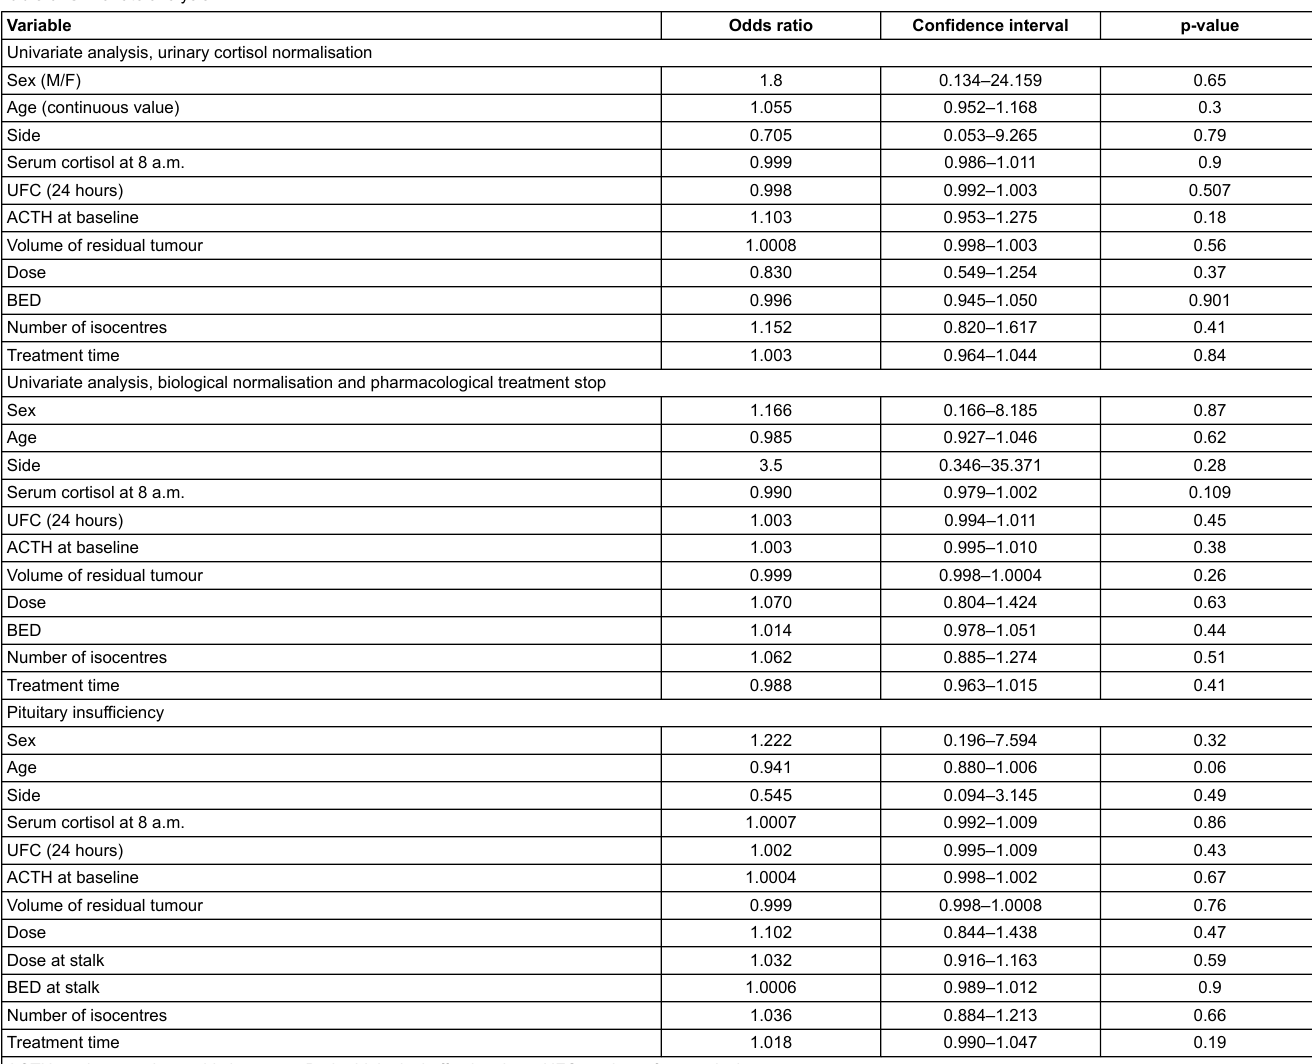
Table 3: Univariate